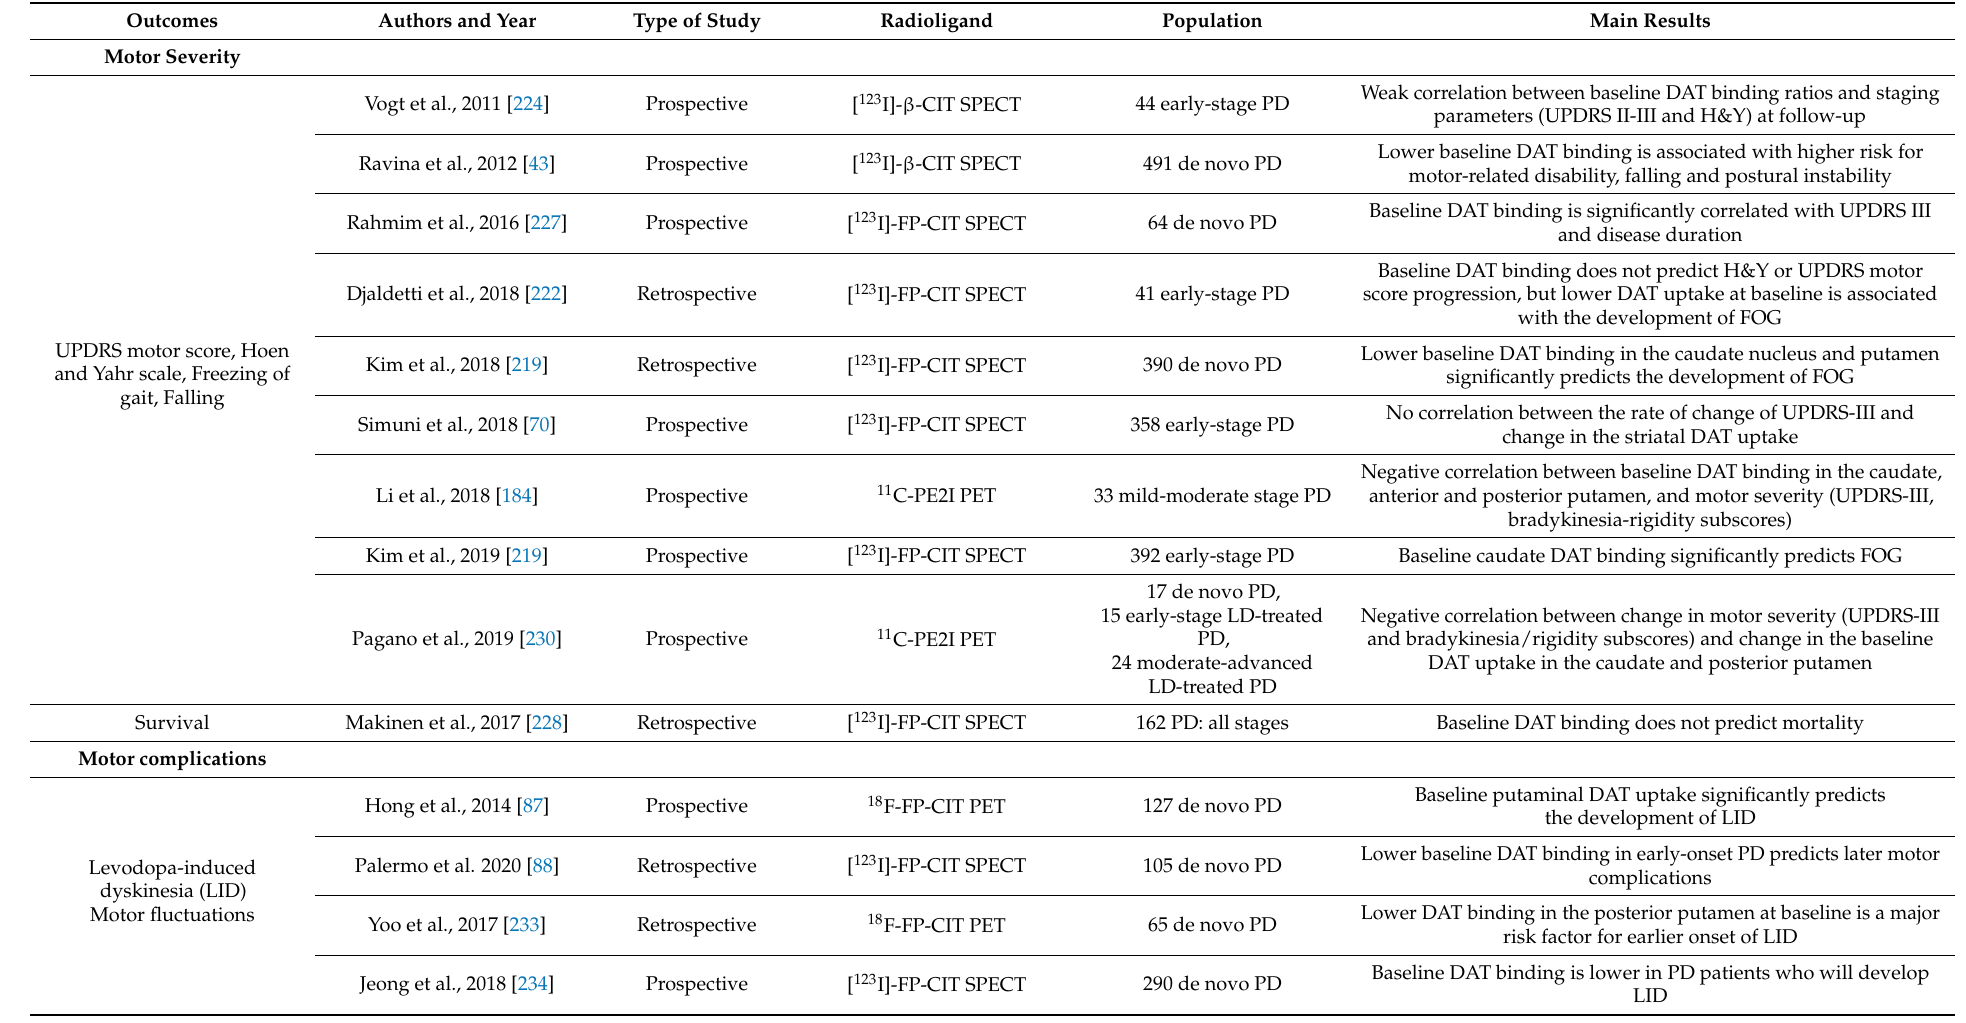
Table 1. DAT imaging as a predictive biomarker in PD: motor and non-motor